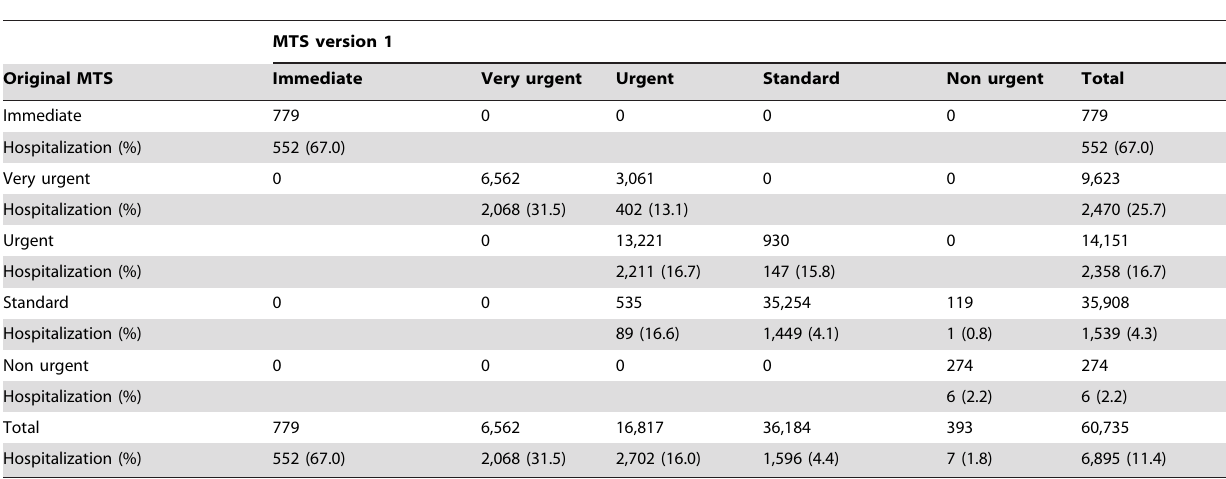
Table 4. Reclassification table: The original MTS compared with MTS version